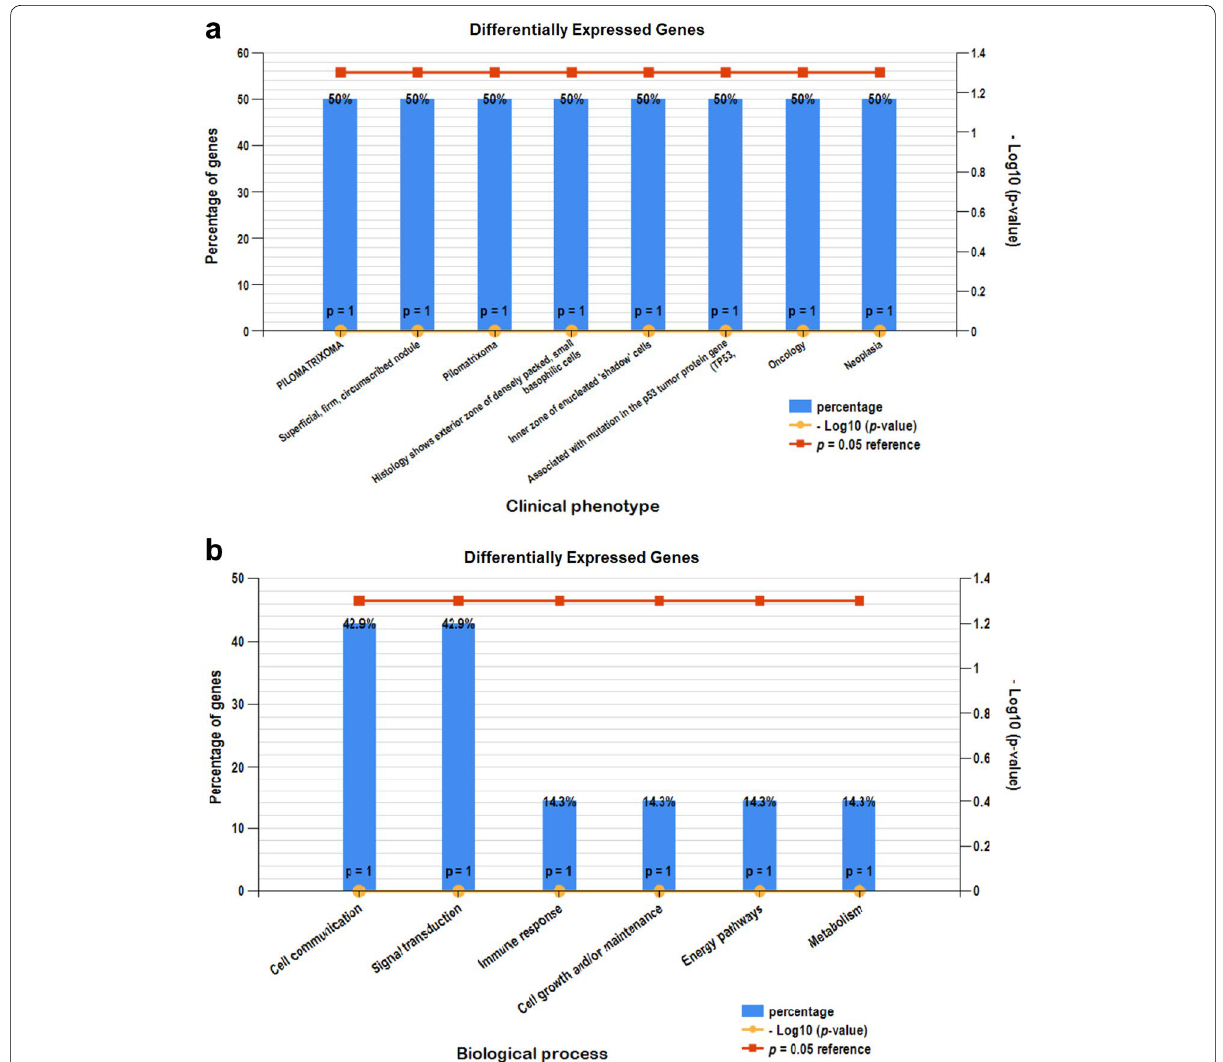
Fig. 4 a Clinical phenotypes analysis of CRC related DEGs. b Biological pathway analysis using FunRich